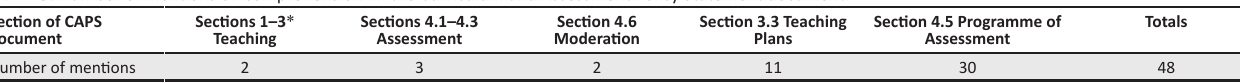
TABLE 3: Number of mentions of ‘comprehension’ in the Curriculum and Assessment Policy Statement document. Section of CAPS document